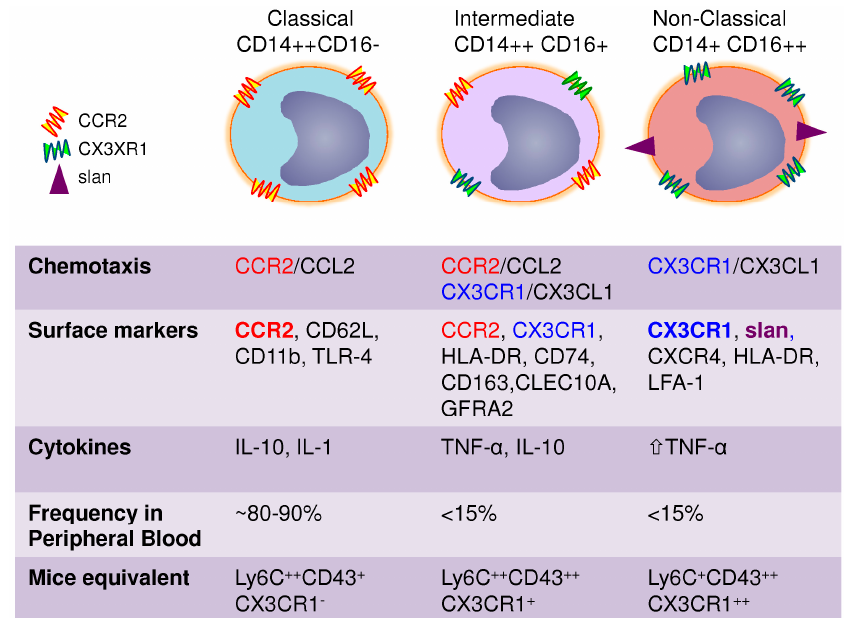
Figure 1. Human monocytes are classified into three subtypes based on the differential expression of CD14 and CD16: classical CD14++CD16 − (also referred as CD14+ or CD14+CD16 − ), intermediate CD14++CD16+ (also referred as CD14+CD16+ or CD14+CD16int/low) and non-classical CD14+CD16++ (also referred as CD14LowCD16+ or CD14dimCD16+)